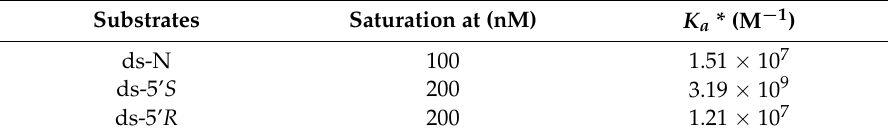
Table 4. Affinity constants ( K a ) of PARP1 binding to substrates .